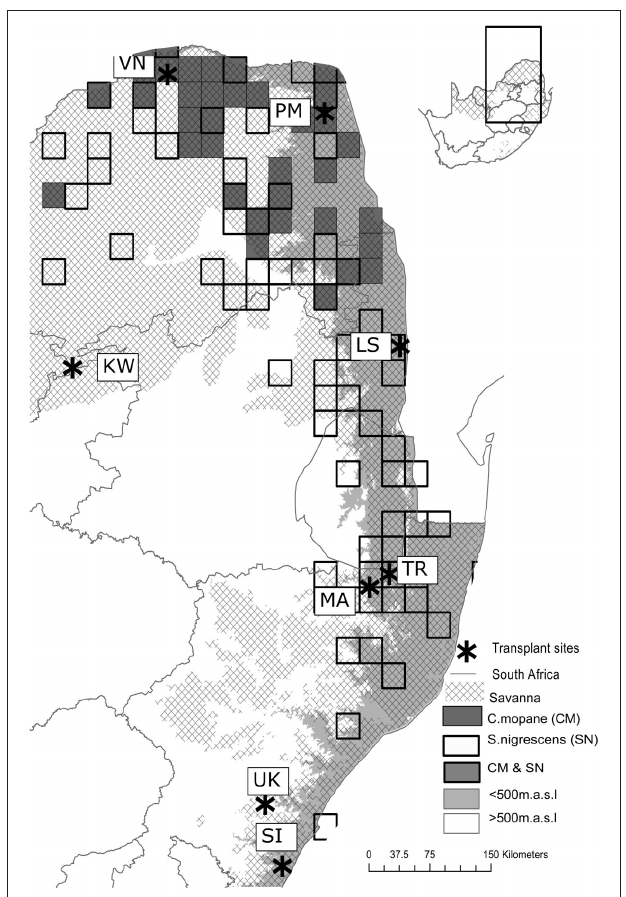
FIGURE 1 | The location of sites across the latitudinal and altitudinal gradient. Four paired sites were placed across a latitudinal gradient. Each site was paired with a higher elevation (white areas) site. The gridded squares indicate the underlying distribution of each of the species planted ( C. mopane = gray squares & S. nigrescens = white squares). All sites were placed within the savanna biome. The northern most sites ( ∼ 22 ◦ 30 ′ S) are referred to as latitude 1 sites and the southernmost sites ( ∼ 30 ◦ 30 ′ S) as latitude 4.